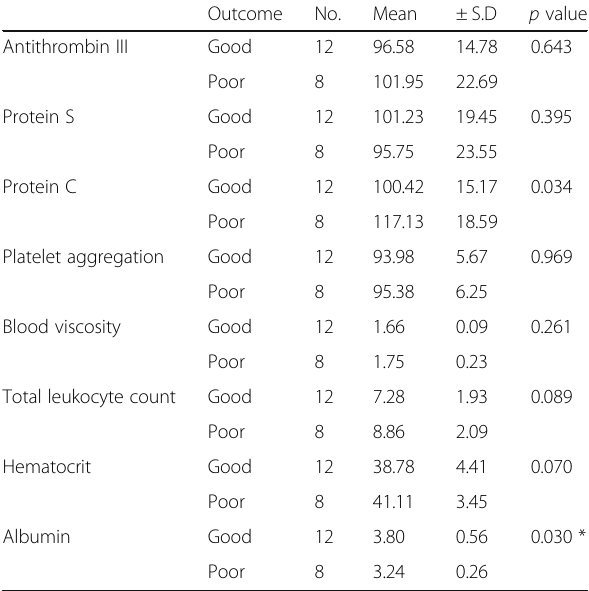
Table 4 Comparison between patient with good and poor outcome as regard laboratory investigations